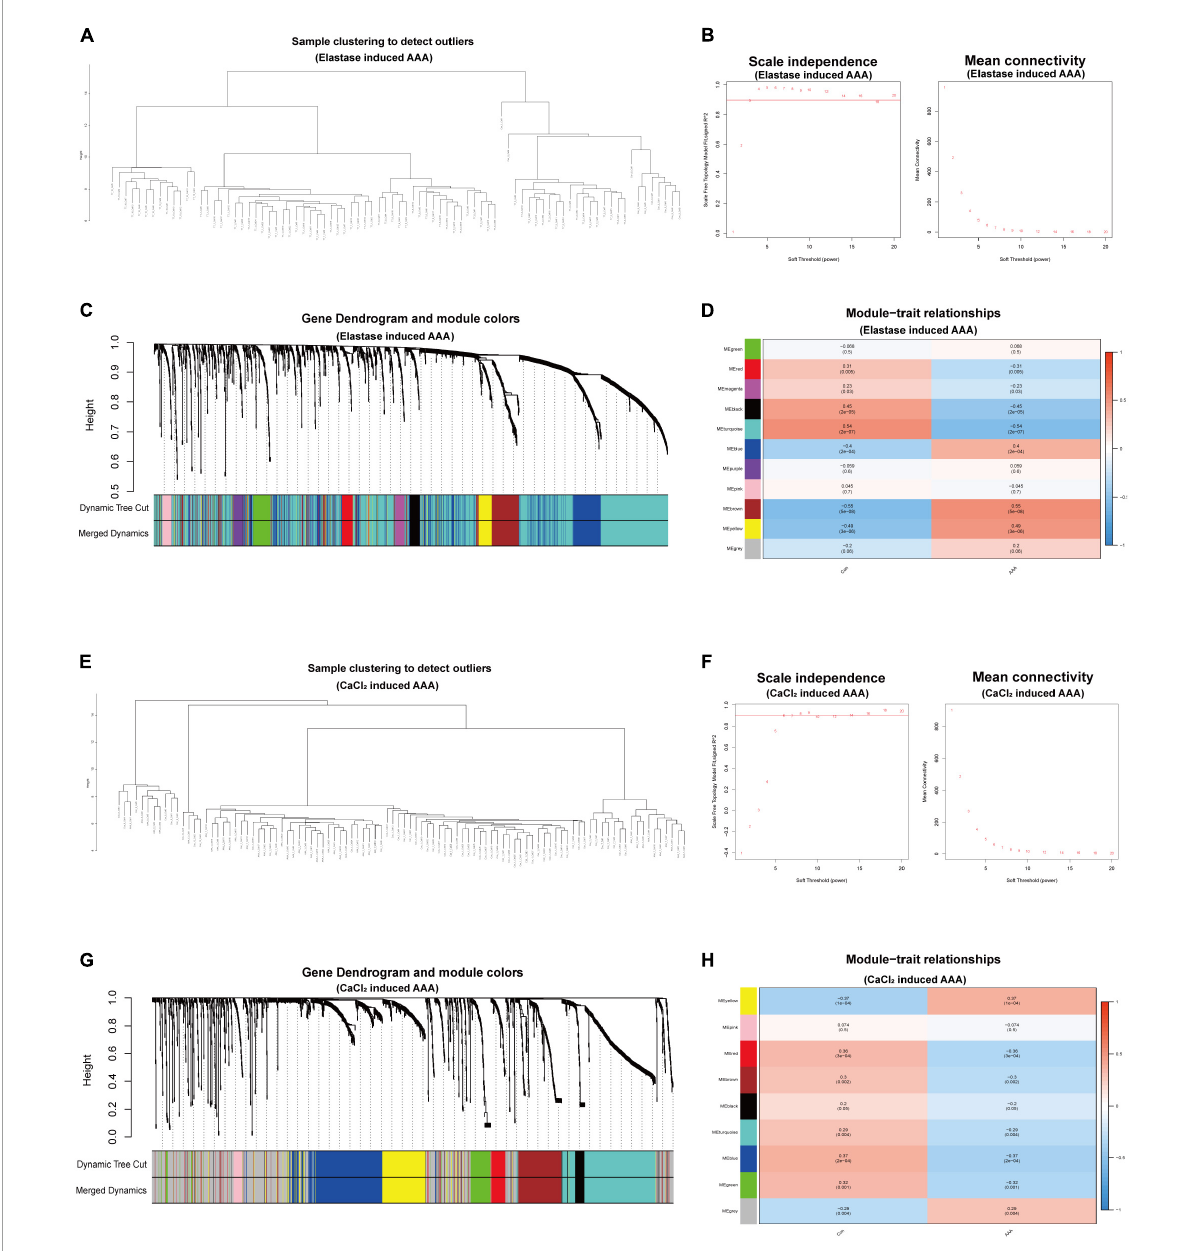
FIGURE2 WGCNA for monocytes/macrophages populations of scRNA-seq datasets. WGCNA for monocytes/macrophages populations from peri-adventitial elastase incubation induced AAA dataset (GSE152583) (A–D) and CaCl 2 induced AAA dataset (GSE164678) (E–H) . Sample clustering dendrogram for the pseudocells (A,E) . Topology network analysis of the scale-free fit index for various soft-thresholding powers ( β ) and the mean connectivity for various soft-thresholding powers (B,F) . The cluster dendrograms represented the co-expression modules (C,G) . Heatmap exhibited the relationships between gene modules and clinical traits (Con and AAA) by Spearman correlation (D,H)